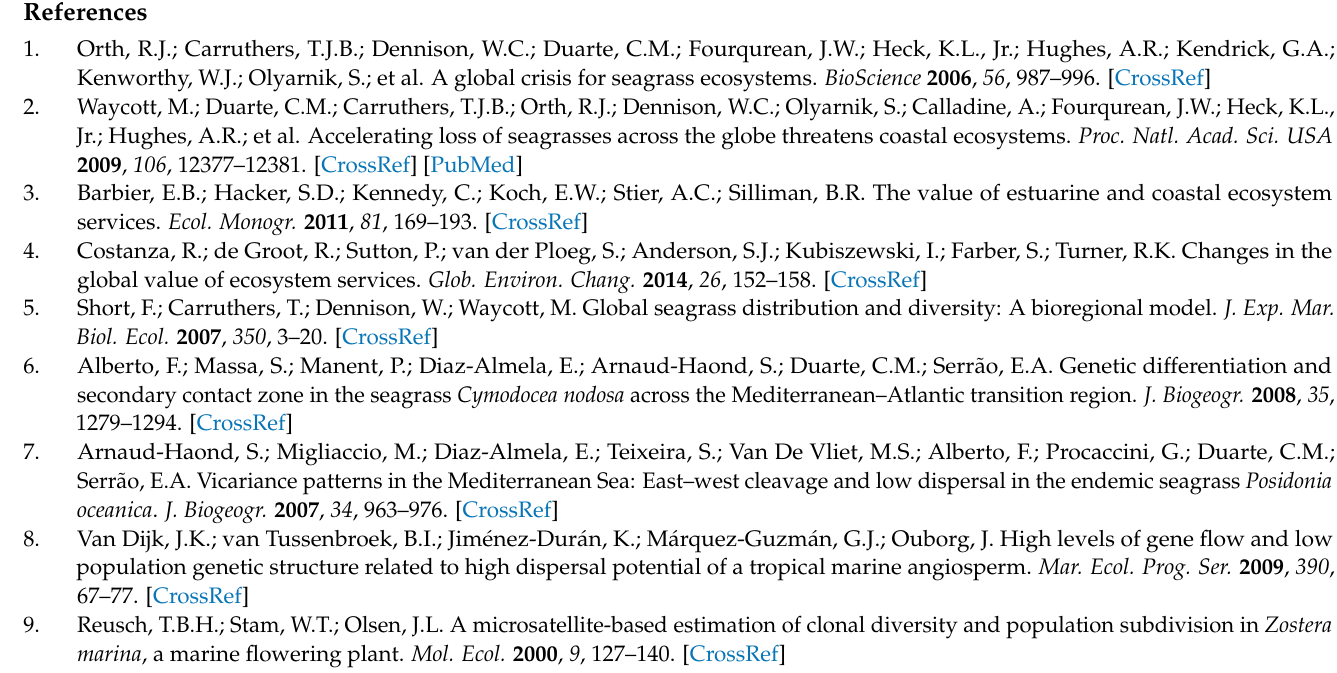
Table S4: Pairwise migration rates for 32 sites using